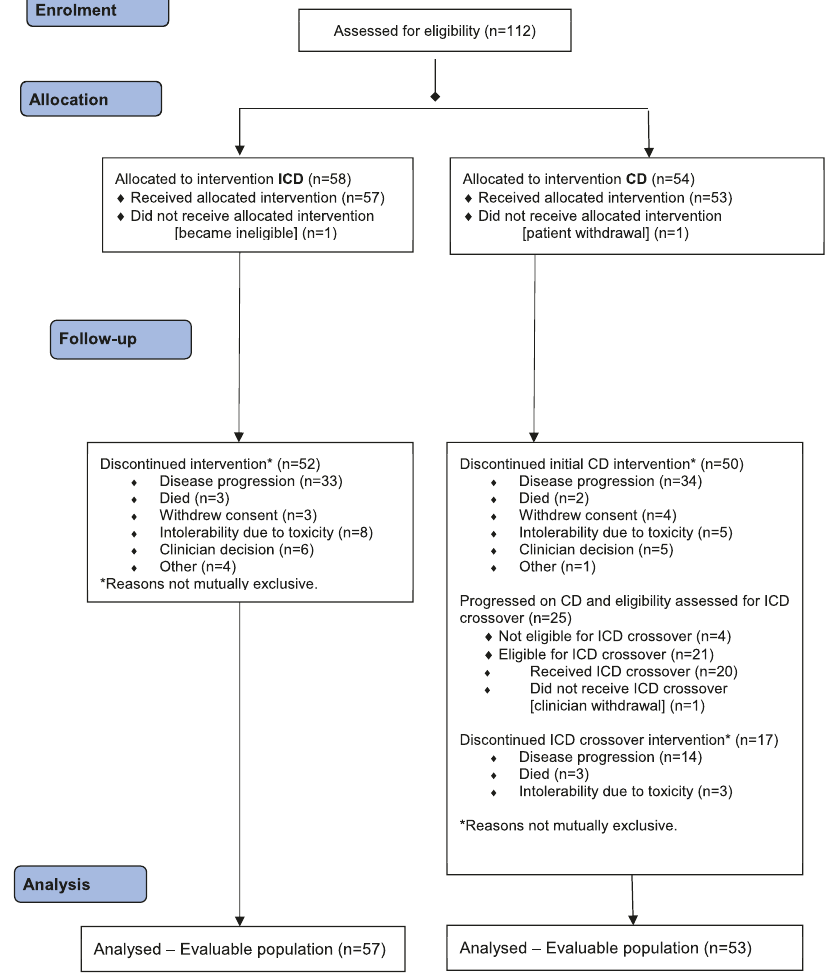
Fig. 1 Clicnial Trial Consort fl ow